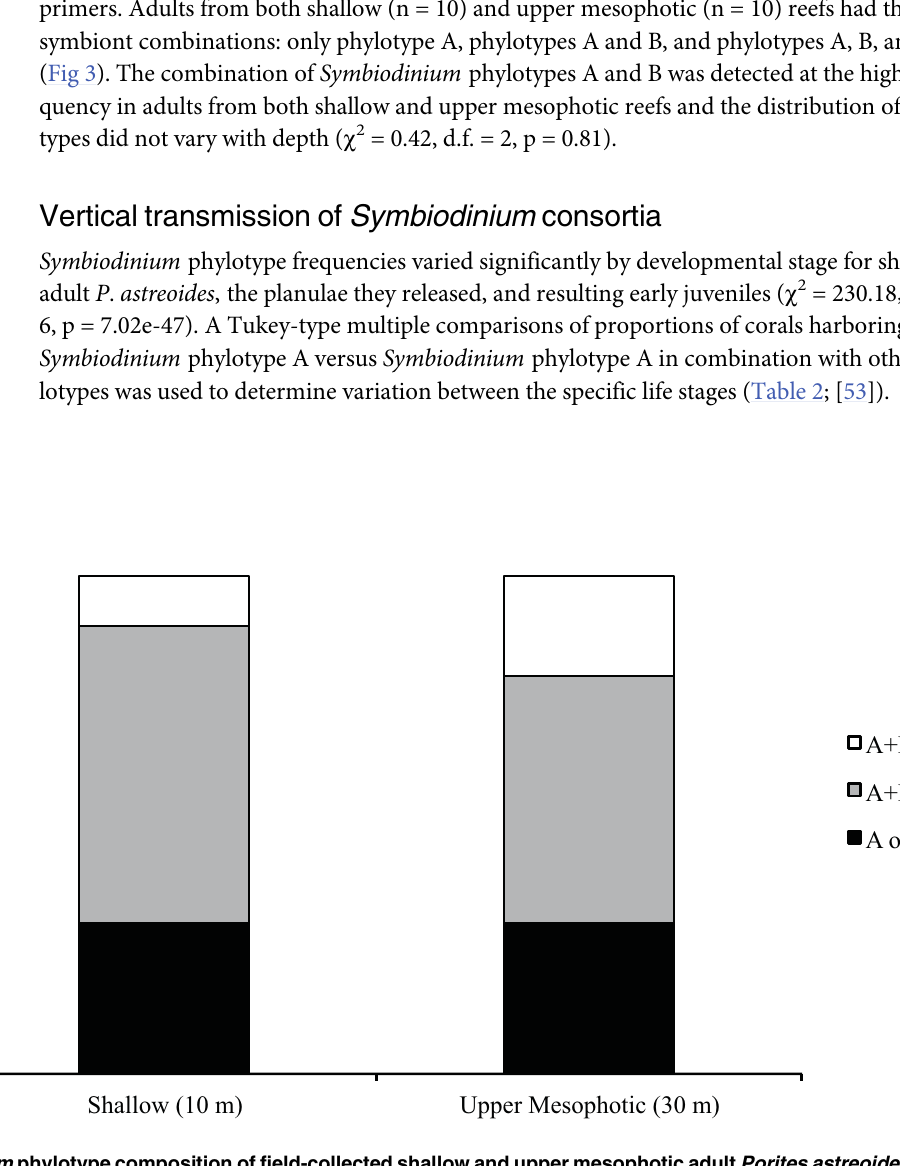
Fig 3. Symbiodinium phylotype composition of field-collected shallow and upper mesophotic adult Porites astreoides . There was no significantdifference in Symbiodinium phylotypefrequency